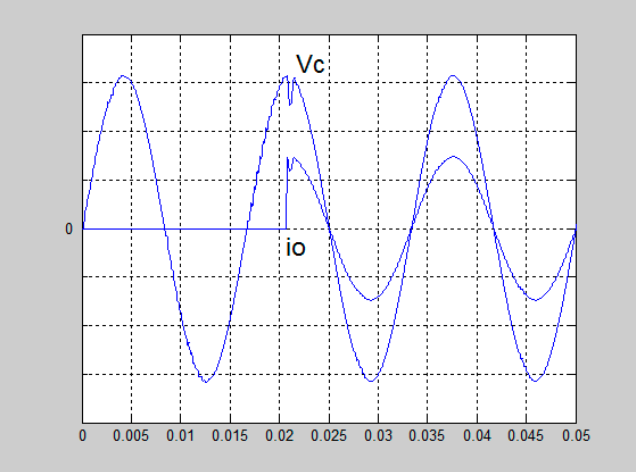
Figure 3. Simulated waveforms under step load change (load suddenly turn on) for the classical TSMC (50 V/div; 10 A/div).